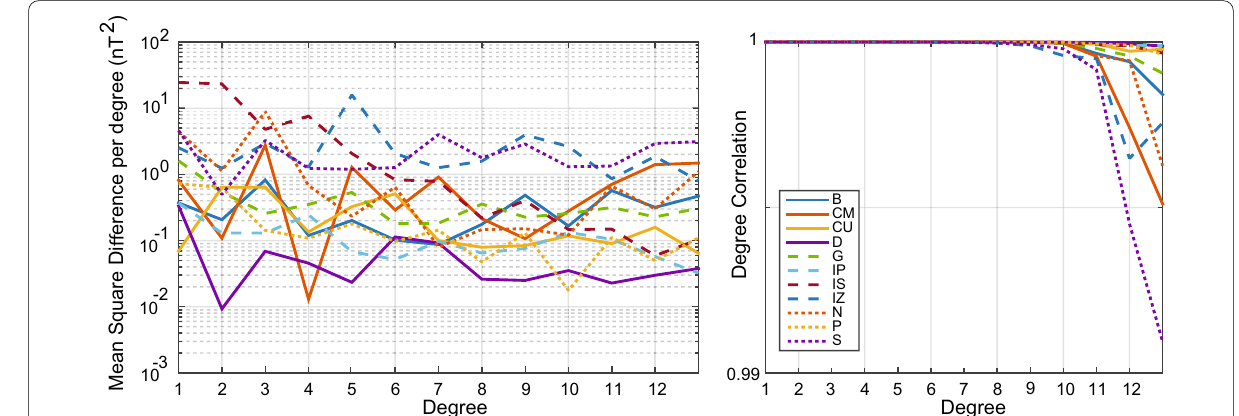
Fig. 1 Power spectrum differences (left) and degree correlation (right) between the DGRF-2015 candidates and the median model